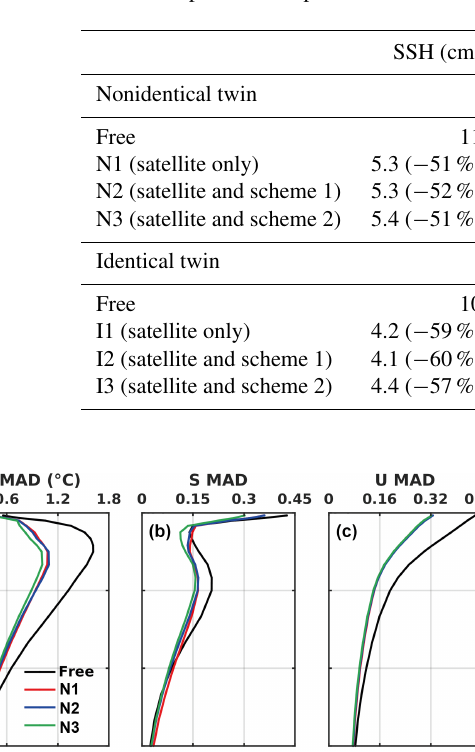
Table 1. Mean absolute deviation (MAD) from the “truth” of physical variables for free and data assimilation runs in nonidentical twin and identical experiments. The MADs were averaged over all grid cells excluding the shelves (defined by water depths < 300m) and daily snapshots from 1 April to 1 October 2010. At assimilation steps the forecast ensemble mean was used for the calculation. The percentage change relative to the free run is presented in parentheses.